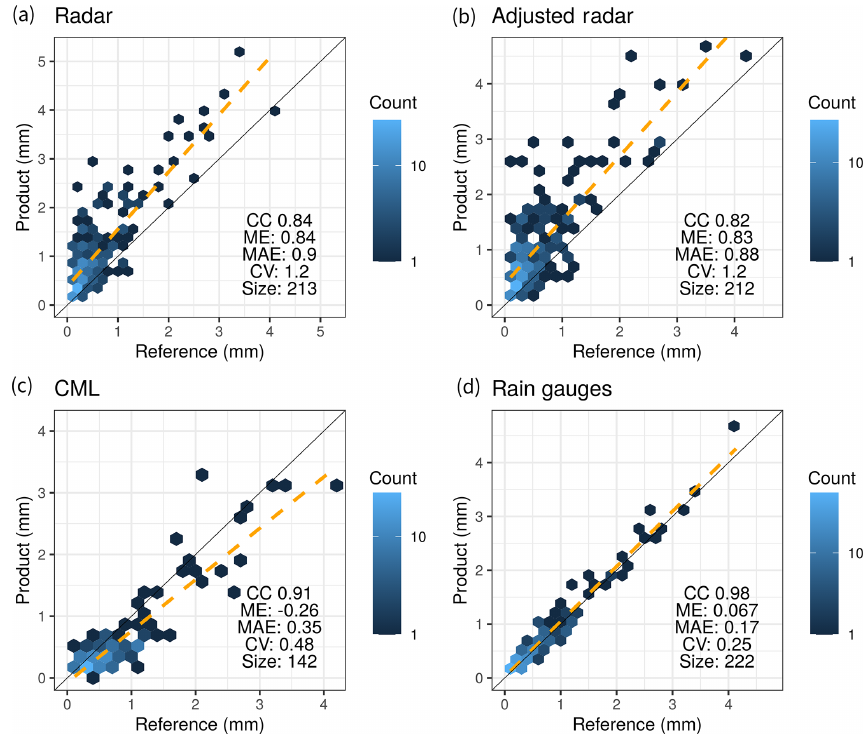
Figure 8. Comparison of hourly areal-averaged rainfall depths from the four products against the ERG5 reference. The total area (TA) wet–wet hours are